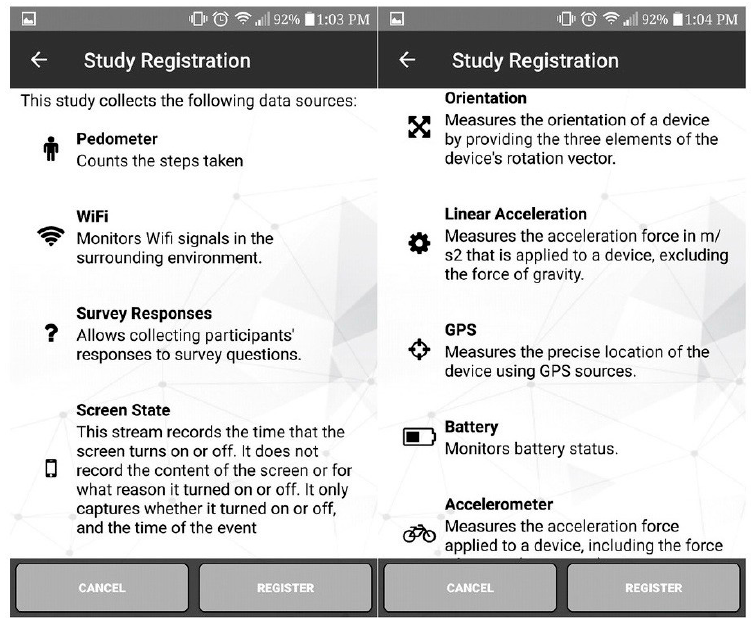
Figure 1. Objective and subjective measures of SMART Platform.